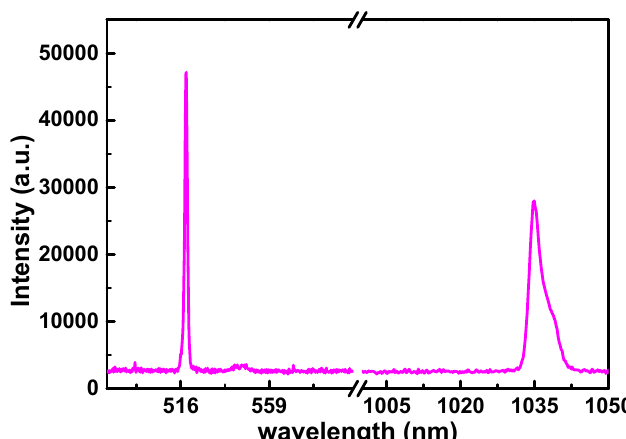
Figure 5. Spectrum of the fundamental and green SDL.